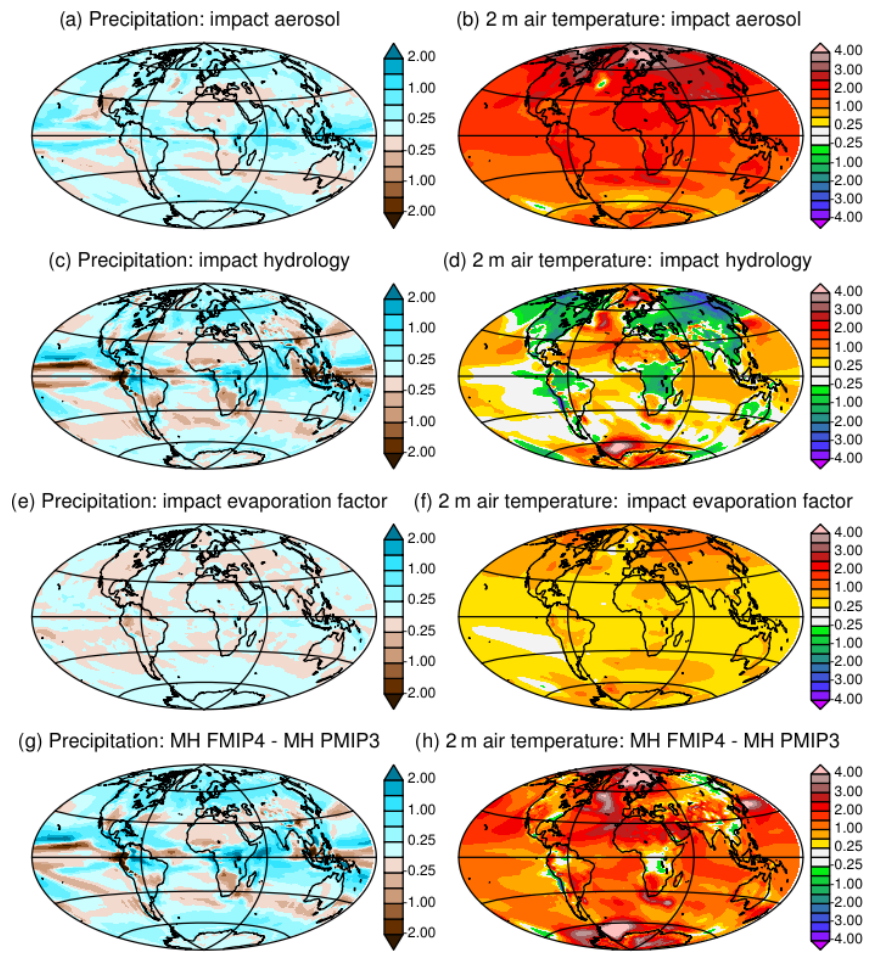
Figure 2. Mid-Holocene annual mean precipitation (mmd − 1 ) and 2m air temperature ( ◦ C) difference between (a, b) L11Aer and L11, (c, d) L11 and PMIP3, (e, f) PMIP3L11AerEv and L11Aer, and (g, h) FPMIP4 and PMIP3. See Table 1 and text for details on the different